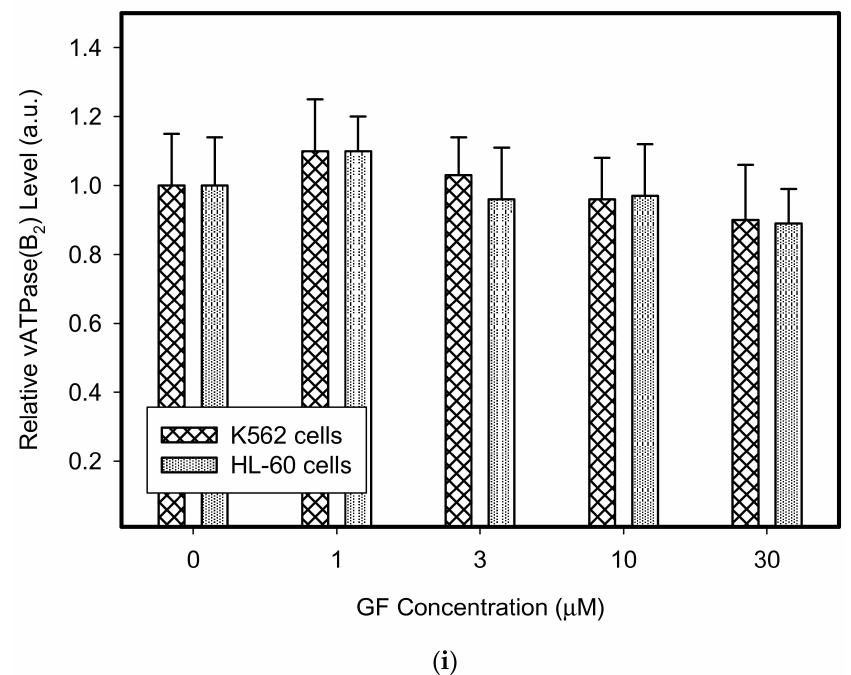
Figure 2. E ff ect of GF on expression of lysosomal proteins in cancer cells. Cells were cultured for 6 h in the presence of GF as indicated, prior to Western blot analysis. Cells cultured in medium without GF were taken as a control. ( a ) Western blot analysis of LAMP1 in K562 cells (typical analysis). ( b ) Western blot analysis of LAMP1 in HL-60 cells (typical analysis). ( c ) Quantitative analysis of LAMP1 expression using densitometry. ( d ) Western blot analysis of LAMP2 in K562 cells (typical analysis). ( e ) Western blot analysis of LAMP2 in HL-60 cells (typical analysis). ( f ) Quantitative analysis of LAMP2 expression using densitometry. ( g ) Western blot analysis of vacuolar ATPase subunit B2 in K562 cells (typical analysis). ( h ) Western blot analysis of vacuolar ATPase subunit B2 in HL-60 cells (typical analysis). ( i ) Quantitative analysis of vacuolar ATPase subunit B2 using densitometry. Results were normalized to β -actin. The results represent the means of four independent experiments with standard deviations.